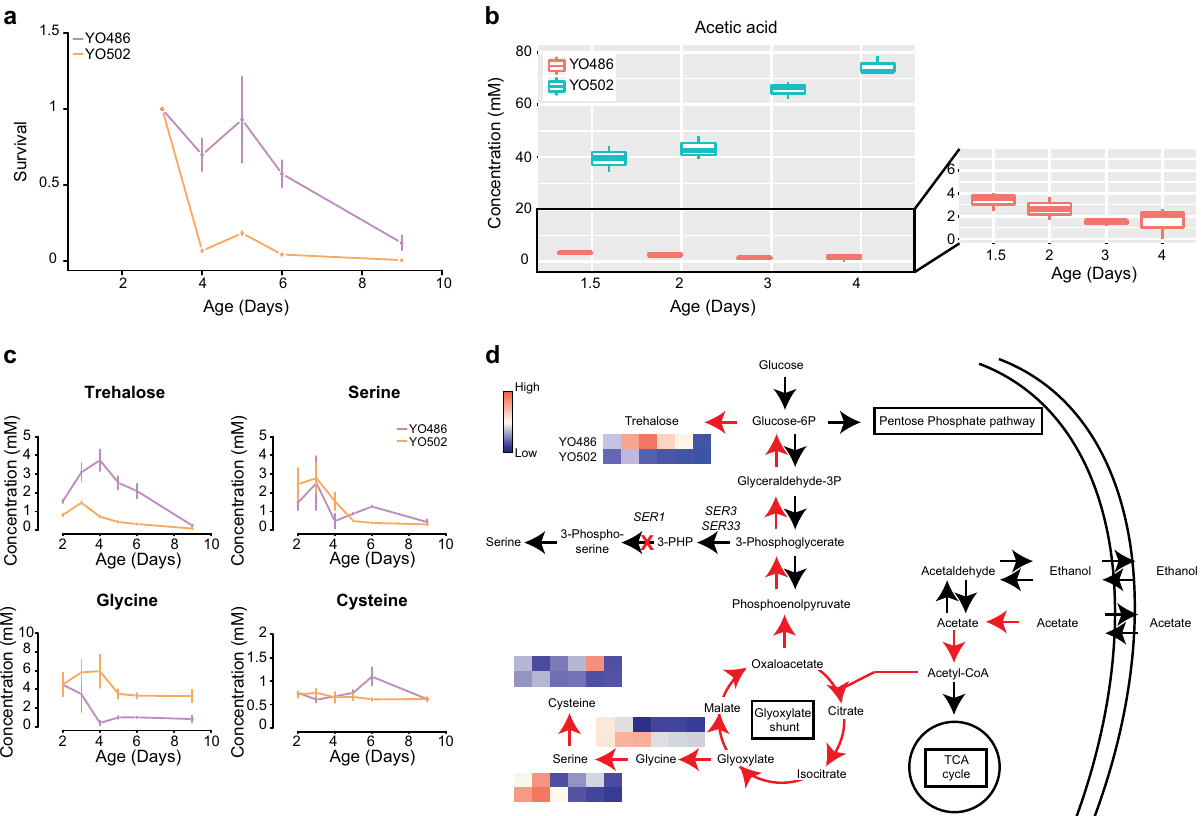
Fig. 6 Metabolome variation during aging for the parental strains of the “ sake × tecc cross ” . a CLS pro fi les obtained for YO486 (violet) and YO502 (orange) from fl ask cultivations in SC medium supplemented with 2% glucose. The aging cultivations were sampled at different time points for endo-metabolome and exo-metabolome analyses. b Acetic acid was quanti fi ed by GC-MS in the extracellular medium of the YO486 (in red) and YO502 (in blue) strains. c Intracellular trehalose, serine, glycine, and cysteine concentrations were also determined during aging in the two strains using LC-MS. d Schematic overview showing the metabolites quanti fi ed in this study within the known metabolic network of S. cerevisiae . The endo-metabolome data is represented by heatmaps where red and blue squares correspond to high and low amounts of each metabolite, respectively, at the different time points. The main serine synthesis pathway, starting from 3-phosphoglycerate, is also shown. The fi rst and second reactions in this pathway are catalyzed by the Ser3 (or its paralog Ser33) and Ser1 enzymes, respectively. It is the latter enzyme that is de fi cient in the YO486 strain (as indicated by the red cross). 3-PHP,